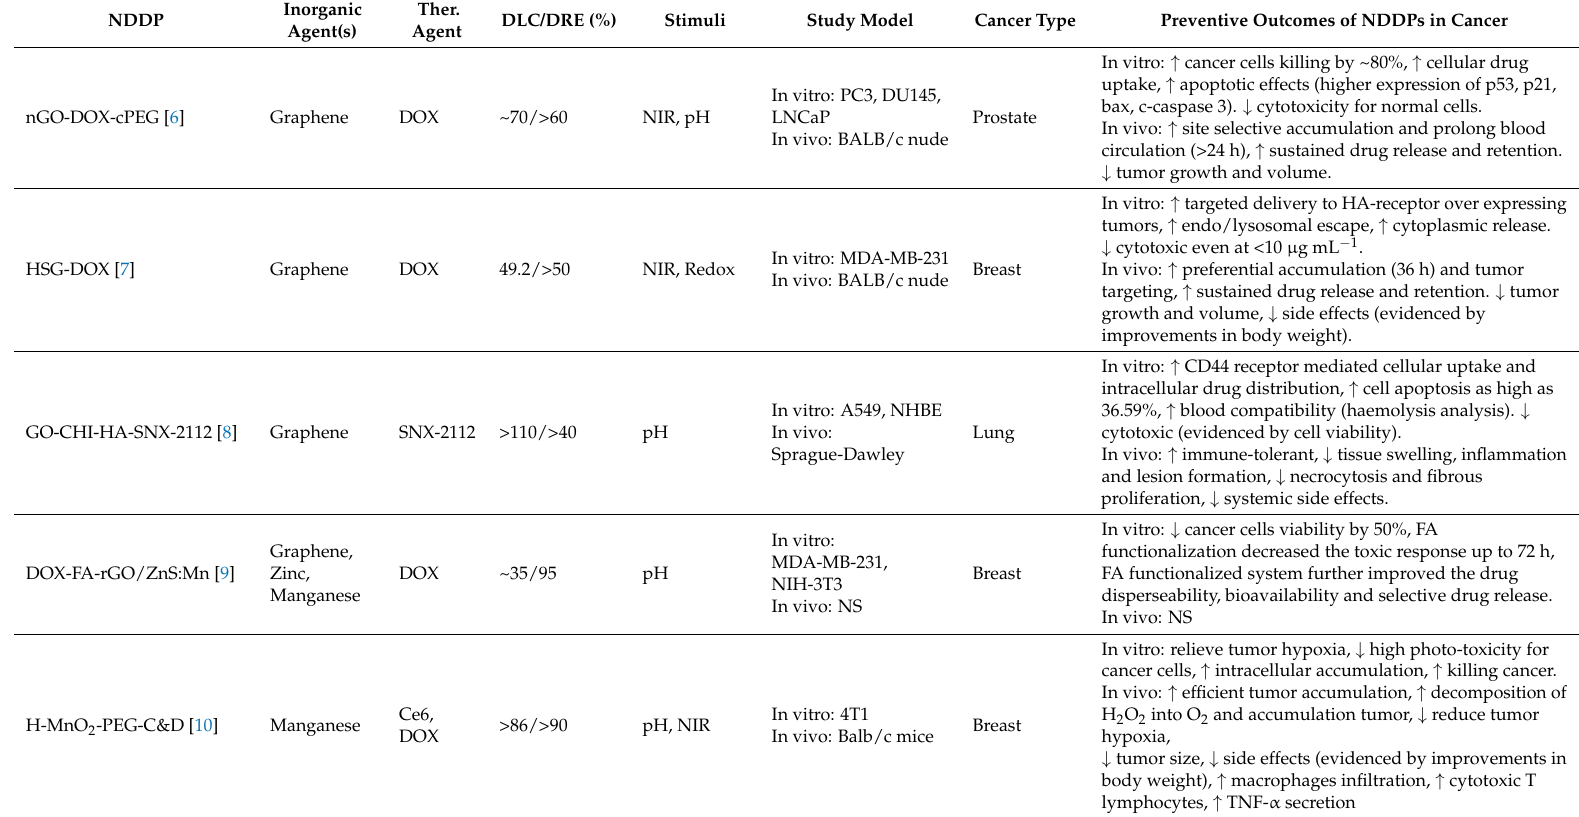
Table 1. Recent experimental (in vitro and in vivo) investigations highlighting the therapeutic potential of inorganic NDDPs for treatment of various cancers.